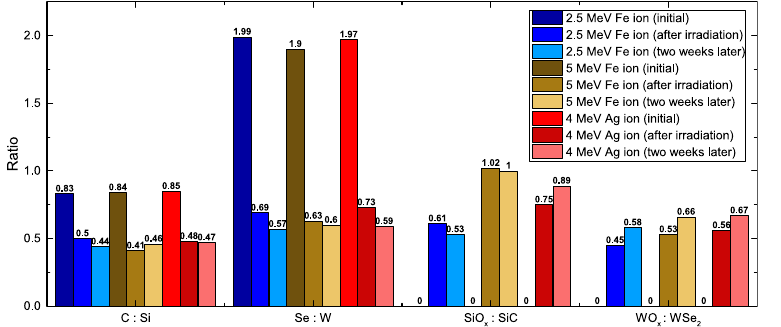
Figure 6. Compositional analysis of WSe 2 /SiC heterostructure from XPS studies. The compositional ratio of C:Si, Se:W, SiO x :SiC and WO x :WSe 2 of WSe 2 /SiC heterostructure before and after heavy ion irradiation. No oxidation of silicon and tungsten has been detected before